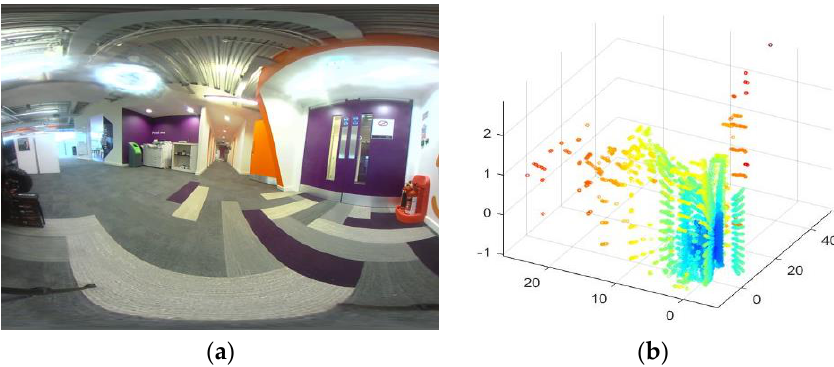
Figure 1. Examples of sensor data to be fused. ( a ) Image from the wide angle camera; ( b ) 3D point cloud from LiDAR.